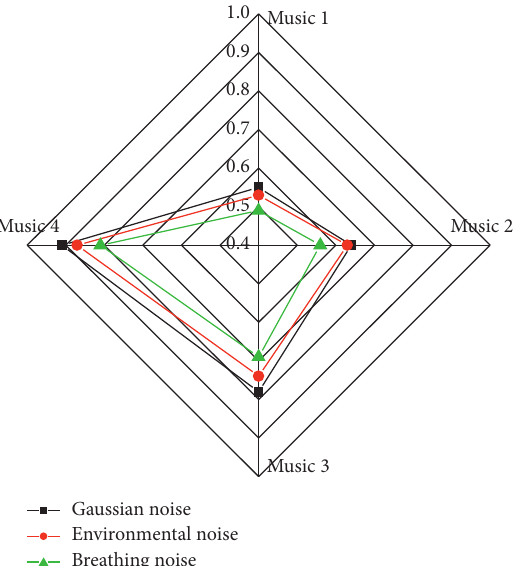
Figure 4: Effect of different noise environments on the success rate of subsequence retrieval.